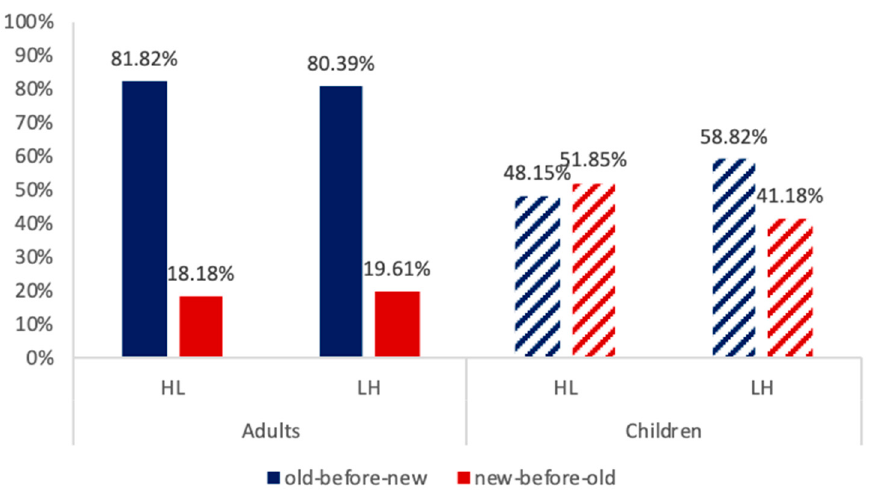
Figure 4. Mean proportions of heavy-light (HL) and LH (light-heavy) conjunct NPs by information structure (IS) in child and adult speech. (HL = first nominal with a heavier weight than the second noun or NP; LH = second nominal with a heavier weight than the first noun or NP).